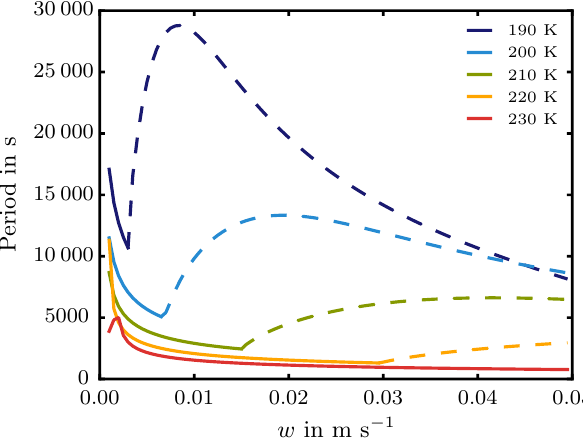
Figure 11. Oscillation periods for the stable focus regime at x 0 (solid lines), and for the limit cycle regime (dashed lines). For the stable focus regime, the periods are obtained from the imaginary part of the complex eigenvalues; for the limit cycle regime, the pe- riods are calculated using the Poincaré map.